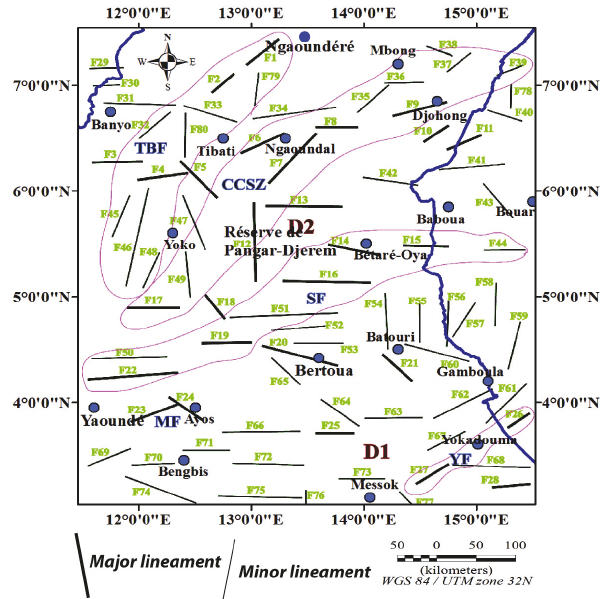
Figure 10: Magnetic lineaments map obtained for the study area showing the TBF, CCSZ, SF, YF, and MF or